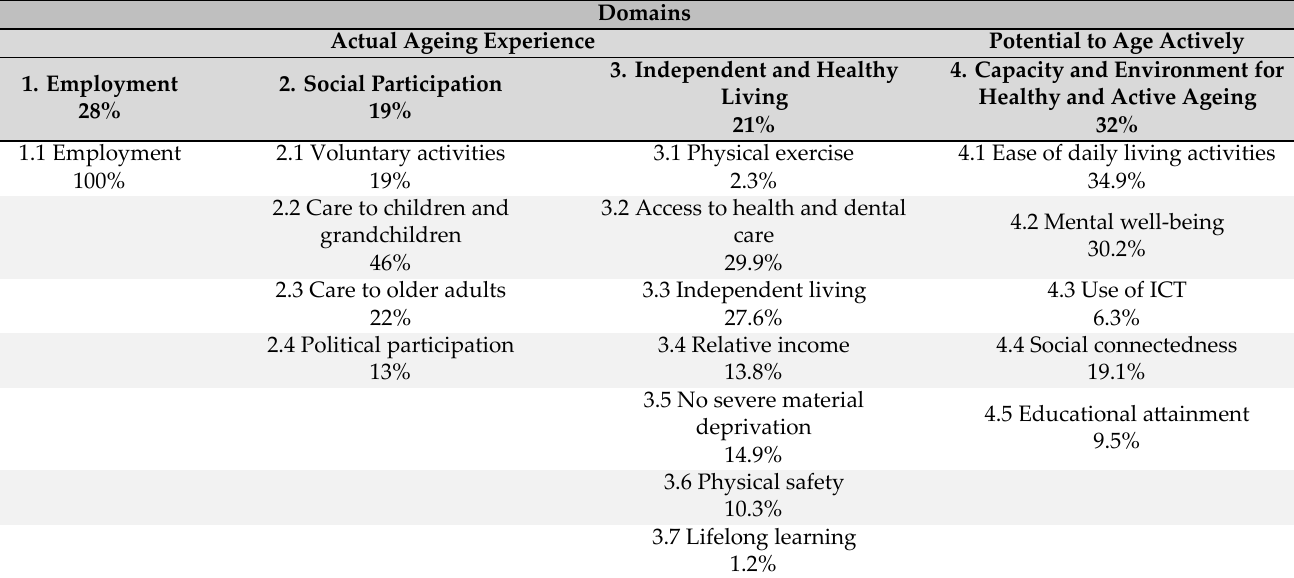
Table 2. The Individual Healthy and Active Ageing